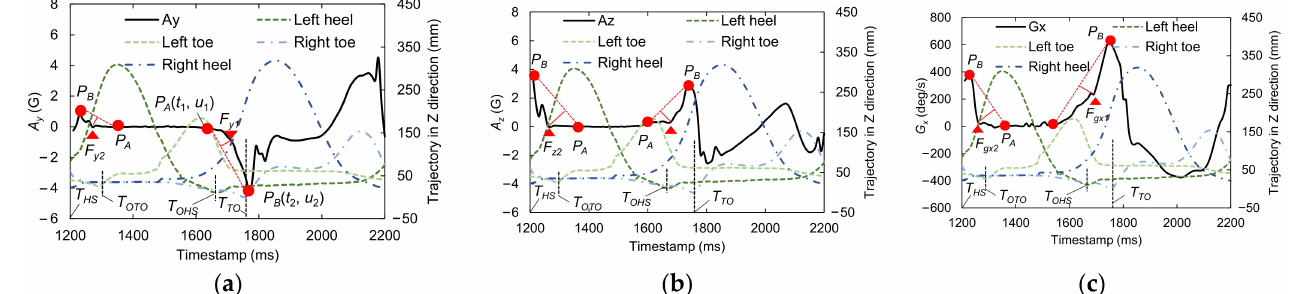
Figure 6. Examples of the foot motion signals, ( a ) A y , ( b ) A z , and ( c ) G x , with candidate feature points for OHS and OTO detection and the marker trajectories in the superior − inferior ( Z ) direction on the left and right heels and